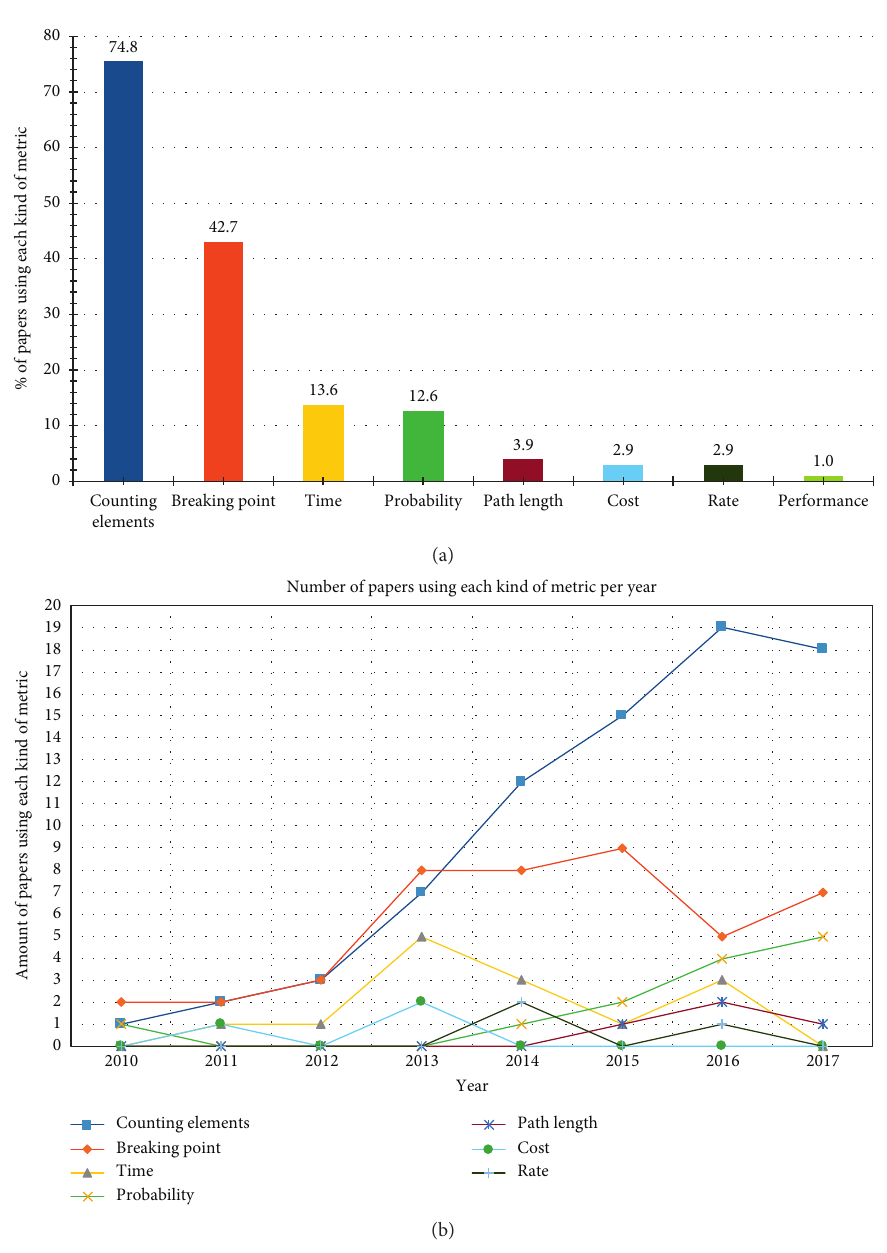
Figure 3: Metric usage among the articles reviewed. (a) Percentage of paper that used each type of metric. (b) Amount of papers per year using each type of